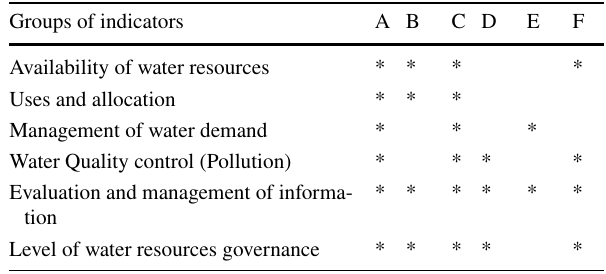
Fig. 7 Roles of stakeholders on Boughrara system Table 4 Rating grid for system evaluation indicators Table 5 Scoring grid of system evaluation indicators